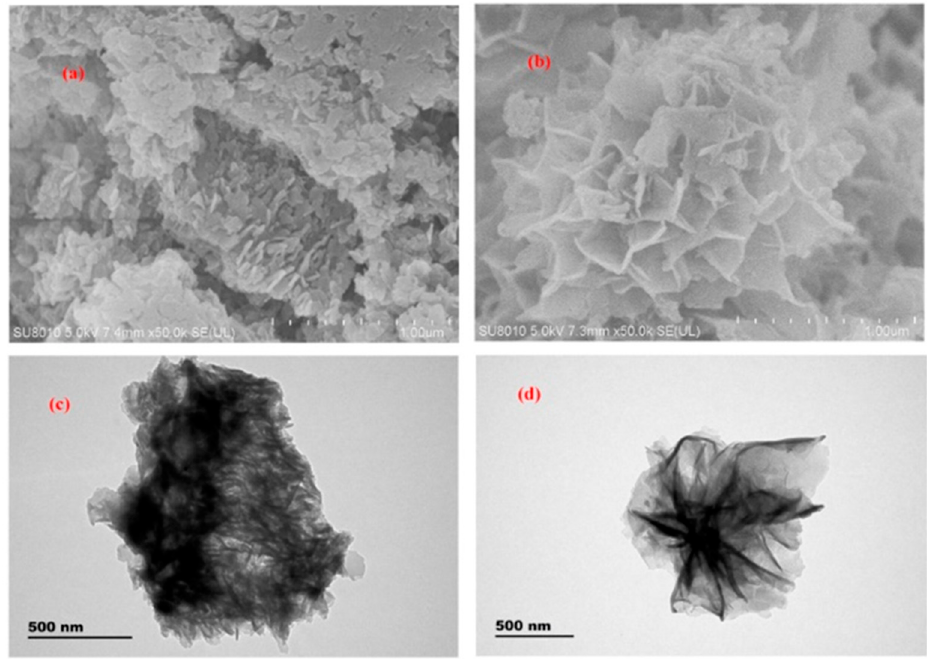
Figure 10. ( a ) SEM images of COFs and ( b ) PS-IL-COFs. ( c ) TEM images of COFs and ( d ) PS-IL-COFs. Reprinted with permission from Ref. [95]. Copyright (2020) Elsevier.